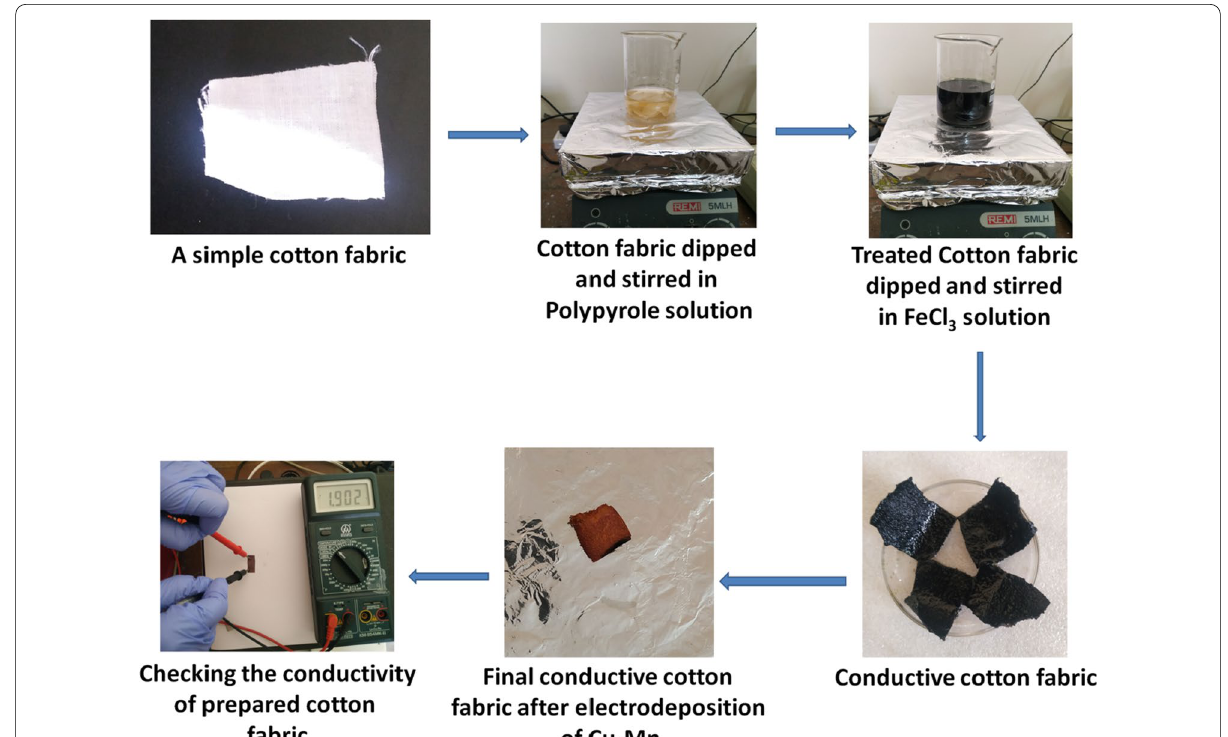
Fig. 1 Pictorial representation of steps carried out in the fabrication